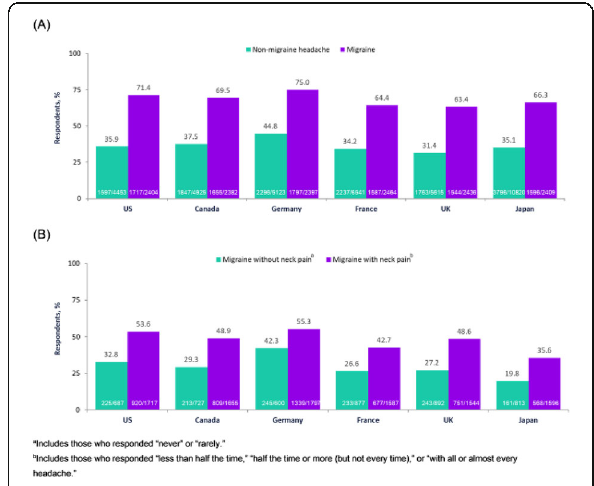
Fig. 1 (abstract P243). (A) Frequency of Neck Pain More Than Rarely Among Individuals With Migraine versus Non-migraine Headache; (B) Frequency of Moderate to Severe Disability Among Migraine Respondents With and Without Neck Pain With Headache